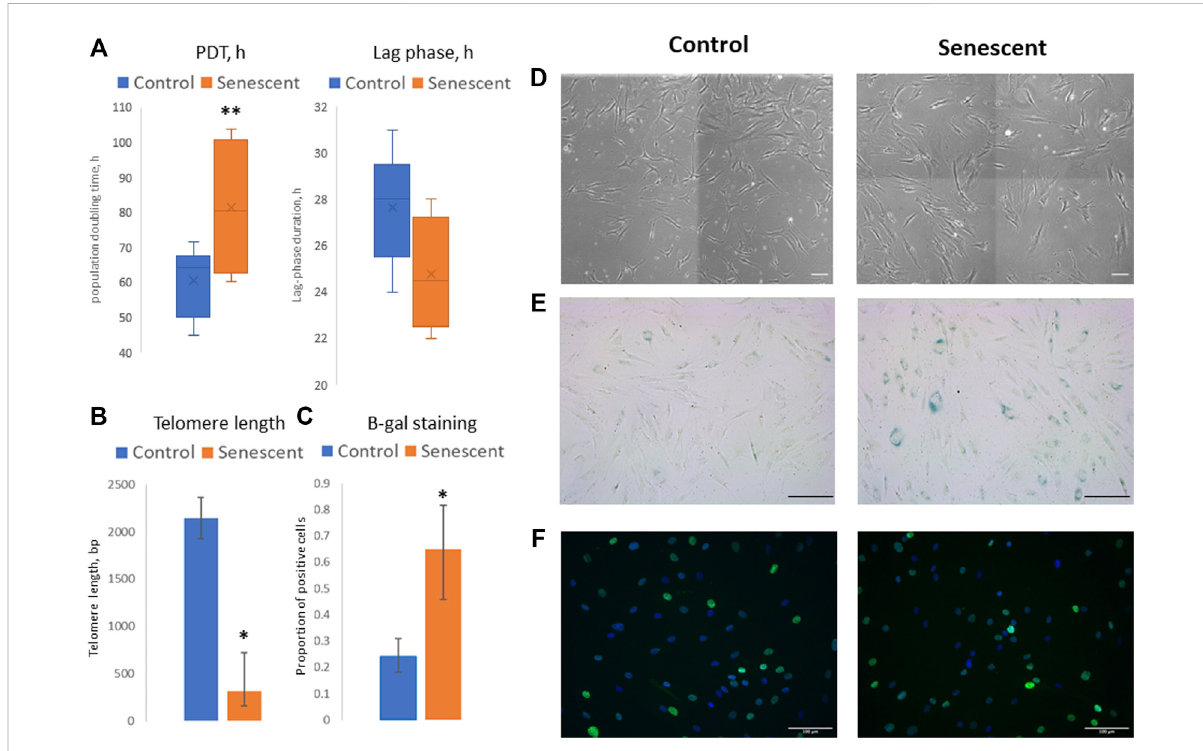
FIGURE 1 Senescent biomarkers in MSCs isolated from young and aged donors. ( A ) — population doubling time (PDT, hours) and lag phase duration (hours) measuredin Incucyte ZOOM system; (B) — telomerelength (bp); (C) — proportion ofcells with positive stainingfor beta-galactosidase(b-gal); (D – F) – representative microphotographs of MSCs isolated from young and aged donors: (D) — cell morphology in culture, phase-contrast images; (E) — b-gal staining, scale bar =100 μ m; (F) — immunocytochemical staining for p21 expression (green), nuclei are stained with